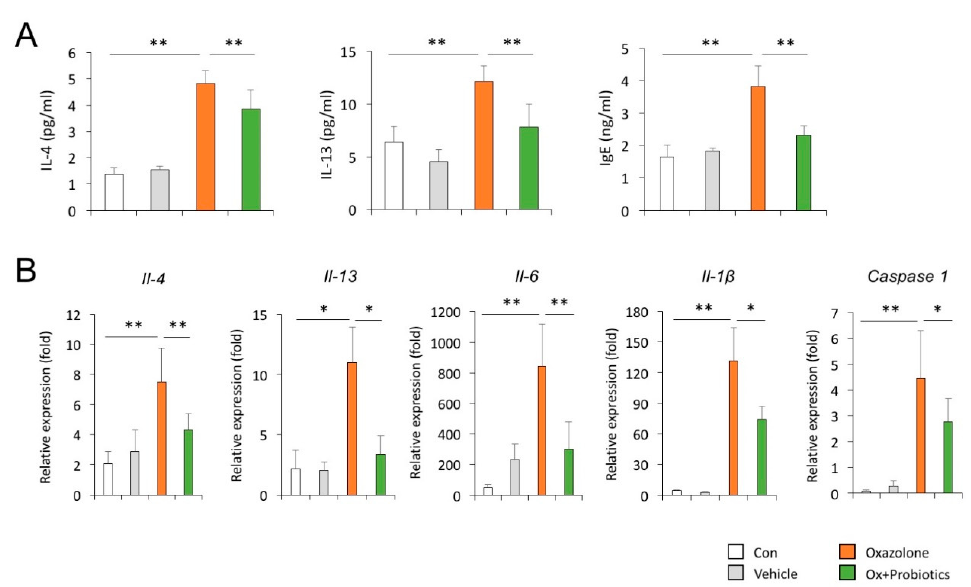
Figure 3. Anti-inflammatory effects of probiotics on the development of AD. ( A ) Serum total IgE, IL-4, and IL-13 levels were determined by ELISA. Con ( n = 3), vehicle ( n = 3), Ox ( n = 5), Ox + probiotics ( n = 5). ( B ) mRNA expression levels of inflammation-related genes were determined by qPCR in dorsal skin tissues. Con ( n = 3), vehicle ( n = 3), Ox ( n = 5), Ox + Probiotics ( n = 5). Data pooled from two independent experiments are presented as the mean ± SD. * p < 0.05, ** p < 0.01.